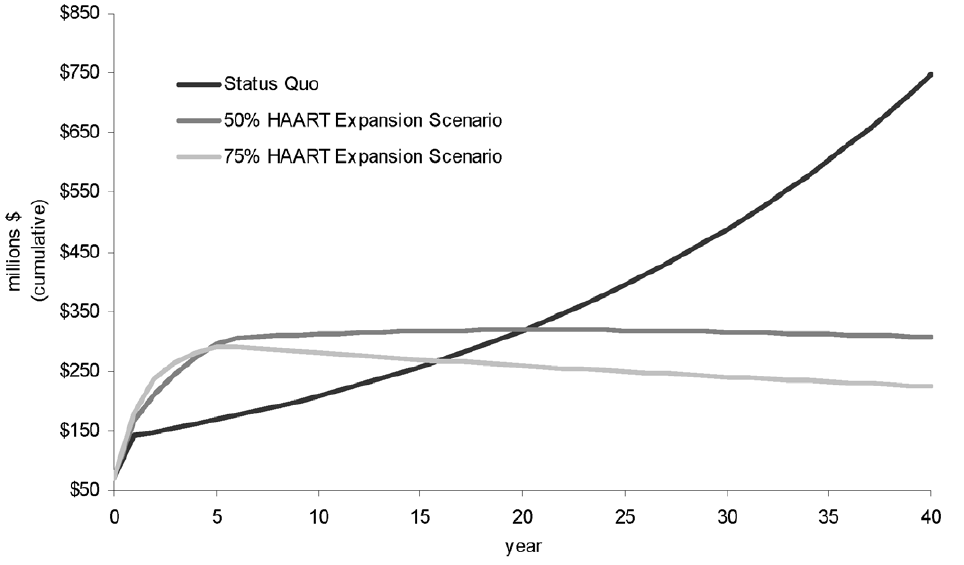
Figure 3. Return on increased investment resulting from implementation of the Status Quo approach versus 50% and 75% expansion scenarios (over 40 years).